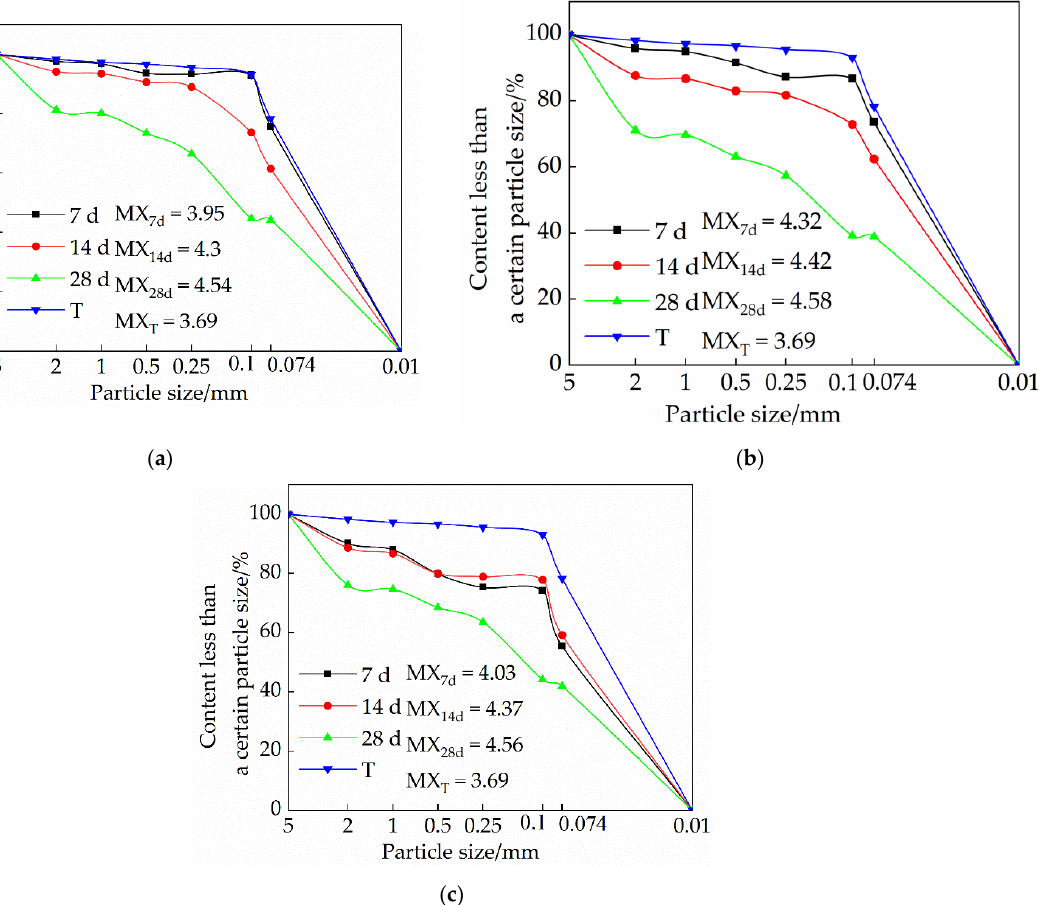
Figure 7. Influence of quicklime on sample particle size distribution: ( a ) Particle size distribution of samples in group S1; ( b ) Particle size distribution of samples in group S2; ( c ) Particle size distribution of samples in group S3.